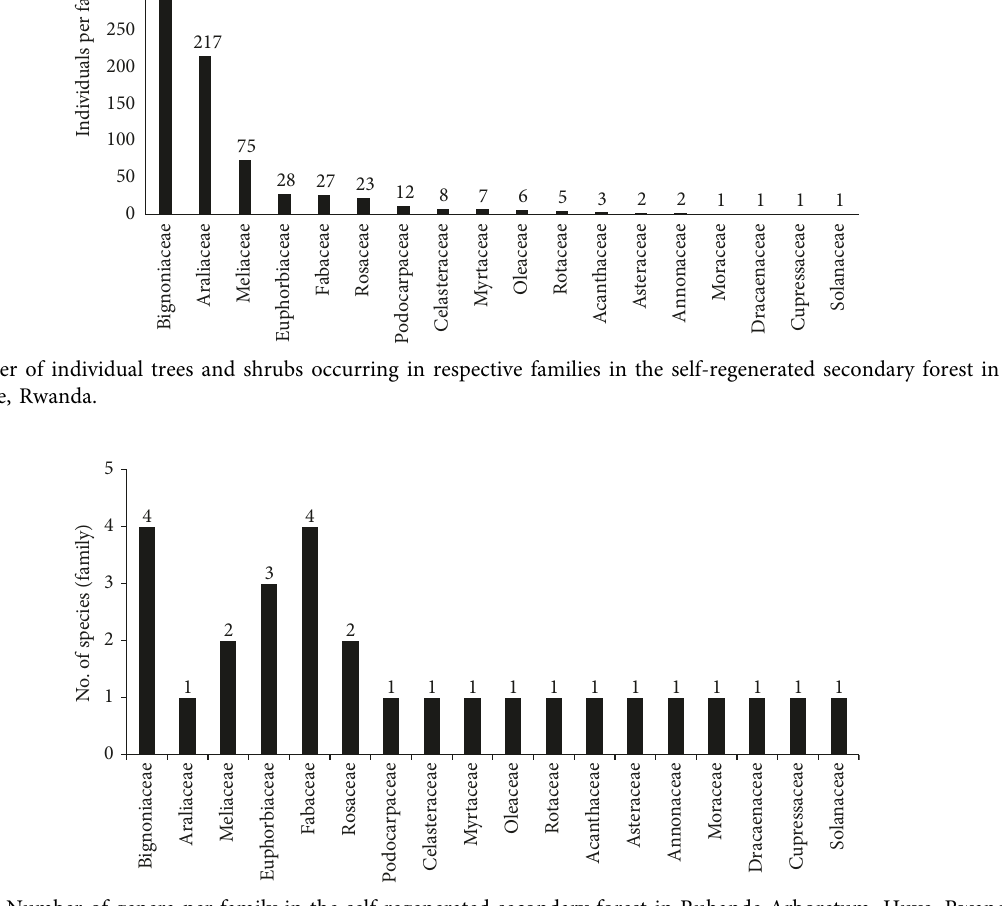
Figure 5: Number of genera per family in the self-regenerated secondary forest in Ruhande Arboretum, Huye, Rwanda.